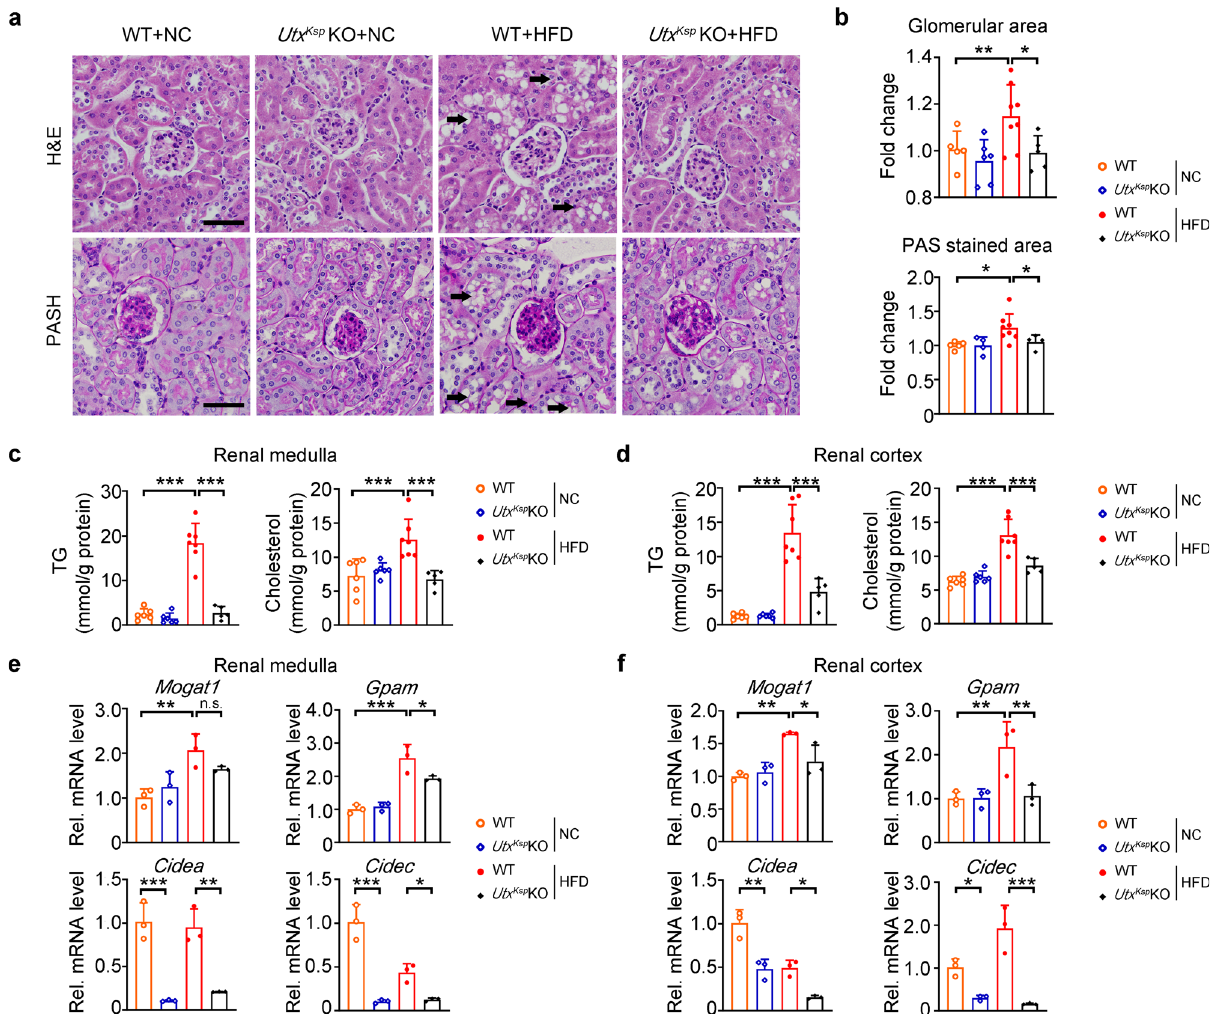
Fig. 2 Reduced glomerular hypertrophy and renal lipid accumulation in Utx Ksp KO mouse under HFD stress. a , b H&E and PAS staining on renal sections of indicated groups ( a ), with quantitative data for relative glomerular area and relative mesanglial area ( b ), data shown as mean±SD. n H&E = 5, 6, 8, 5 independent animals for WT + NC or Utx Ksp KO + NC or WT + HFD or Utx Ksp KO + HFD group, respectively, ** P H&E (WT + NC vs WT + HFD) = 0.0075,